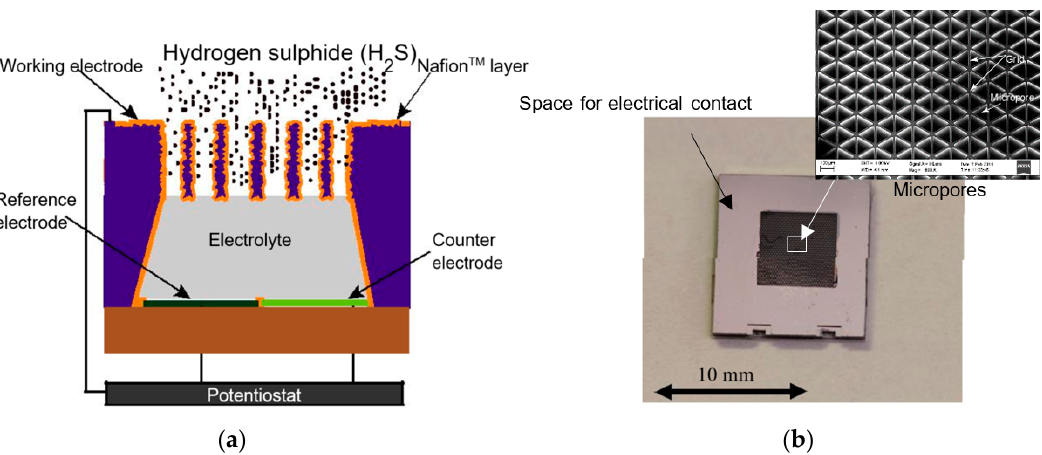
Figure 1. ( a ) Schematic cross section of the sensor design indicating the high aspect ratio micropores with a nanostructured porous Nafion™ layer. ( b ) Photograph of the amperometric sensor with the porous structure in the middle (dark area). Inset: SEM image shows the microporous grid structure of the working electrode. The working electrode of the sensor is fabricated by deep reactive ion etching and platinum atomic layer deposition of a silicon on insulator (SOI) wafer, and the counter and reference electrodes are fabricated on a glass wafer, which is then assembled together by anodic bonding [13]. The sensor has a footprint area of 10 × 10 mm 2 and a thickness of approximately 1 mm.